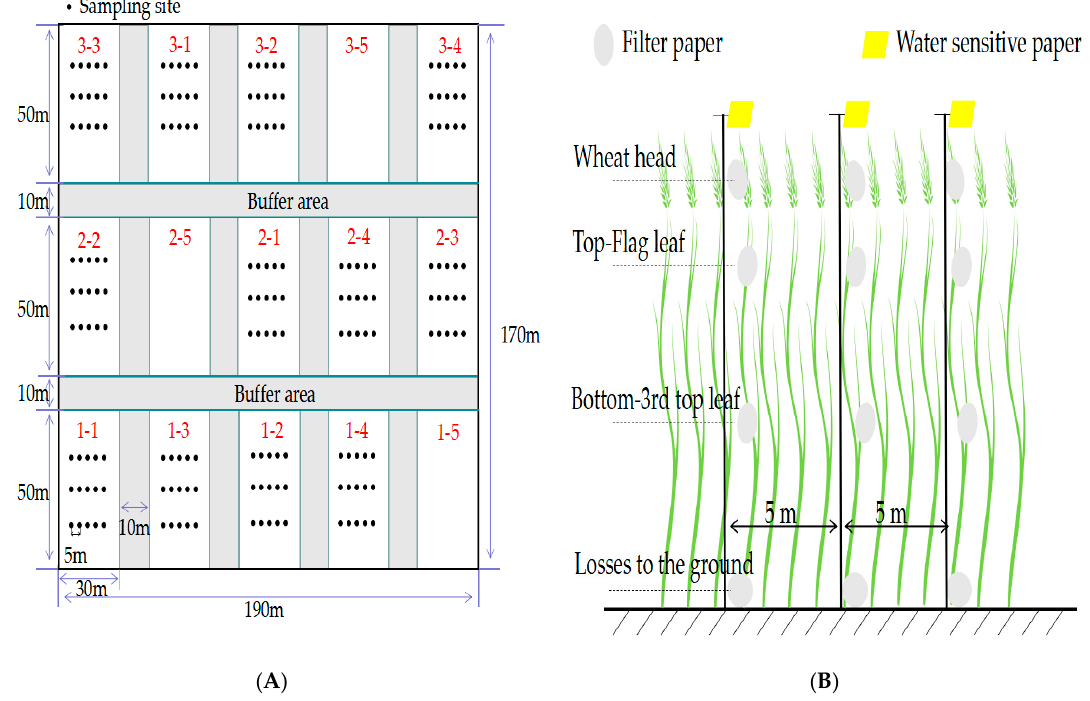
Figure 3. ( A ) Experimental layout of each treatment; and ( B ) placement of filter papers and water-sensitive paper at each sampling position within the wheat canopy.